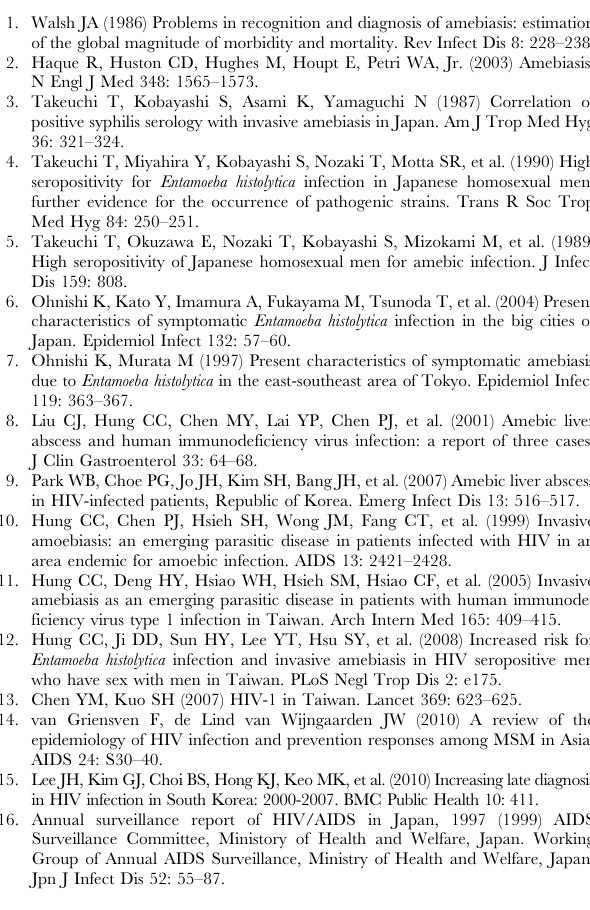
Table S1 Patient demographics with and without luminal treatment. Table S2 Genotyping data of 6 STR loci in 14 clinical samples.